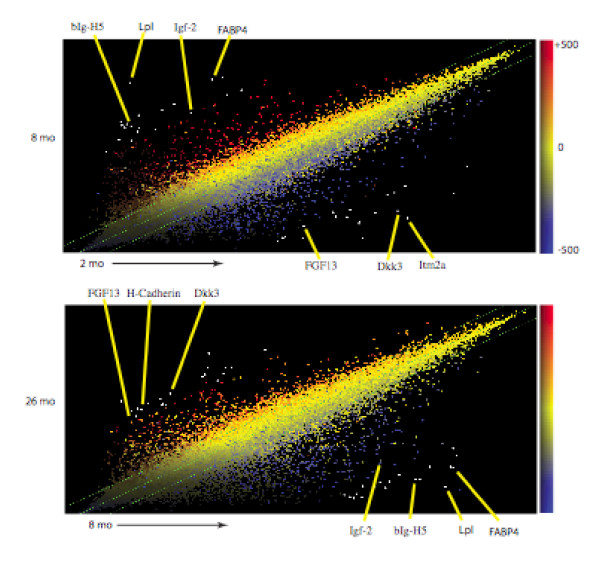
Scatter Plot Analysis Indicating up and down regulated genes from microarray.  This figure indicates the global changes in gene expression during two phases of aging and growth.  While the two figures look similar, the identification of the genes reveals two different gene sets.  Some of the genes that undergo some of the largest changes are indicated.